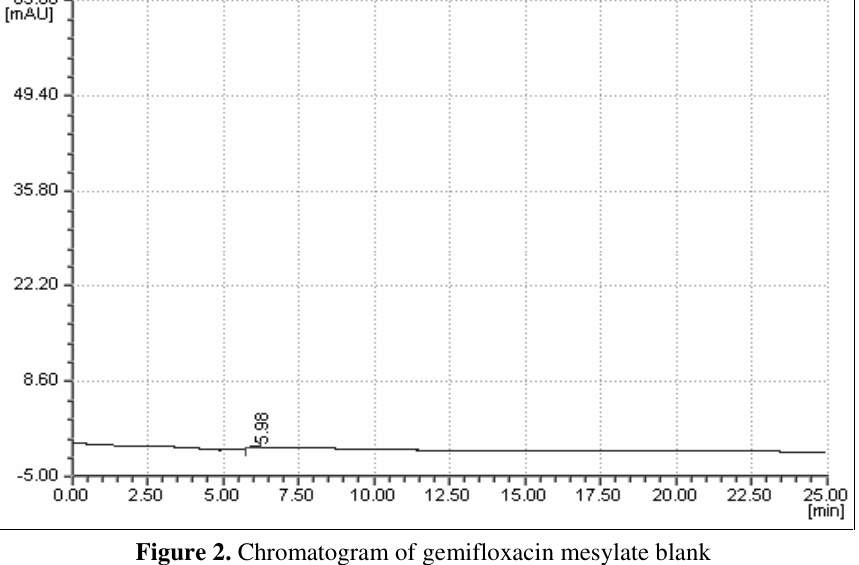
Figure 2. Chromatogram of gemifloxacin mesylate blank